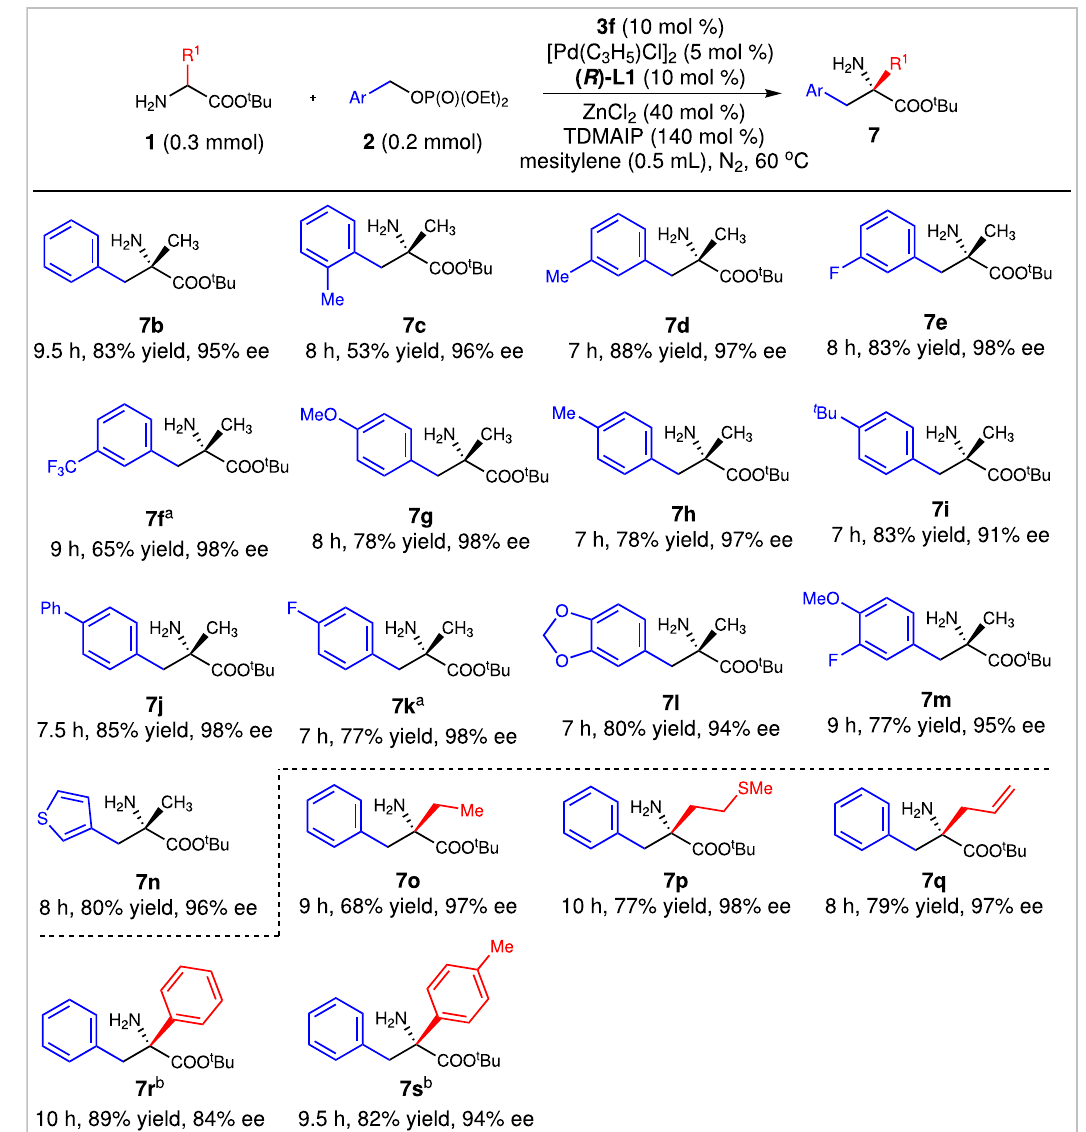
Fig. 4 Substrate scope of monocyclic benzyl alcohol derivatives and amino acid esters. Reaction conditions: 1 (0.30 mmol), 2 (0.20 mmol), 3f (0.02 mmol), ( R )- L1 (0.02 mmol), [Pd(C 3 H 5 )Cl] 2 (0.01 mmol), tris(dimethylamino)iminophosphorane (TDMAIP, 0.28 mmol), and ZnCl 2 (0.08 mmol) were stired in mesitylene (0.5 mL) at 60 °C under the nitrogen atmosphere for indicated time. Isolated yields. The enantioselective excess (ee) was determined by HPLC. a Ee values were given by the N-Cbz-protected derivatives. b With 10 mol% palladium, 20 mol% ( R )- L1 , and at 80